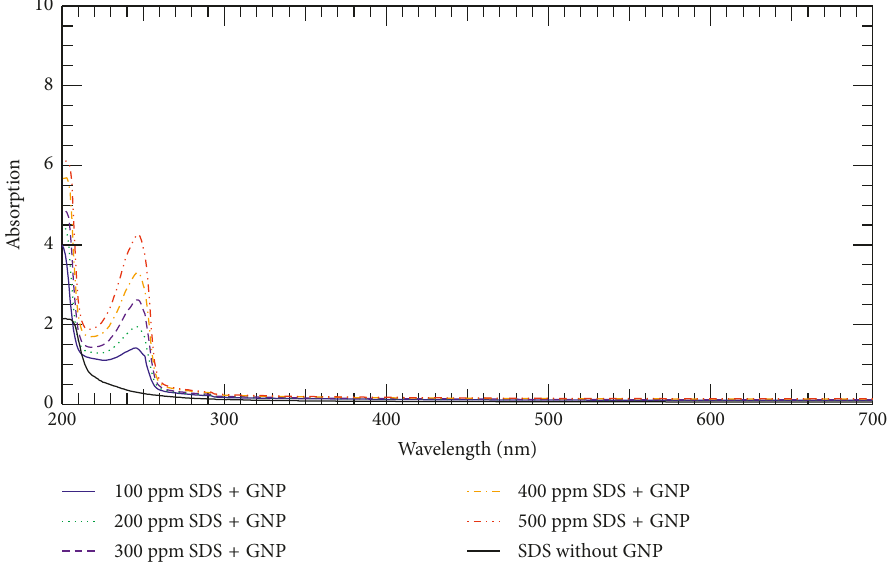
Figure 6: UV-Vis spectra of graphene nanoplatelets in SDS solutions after 30-minute